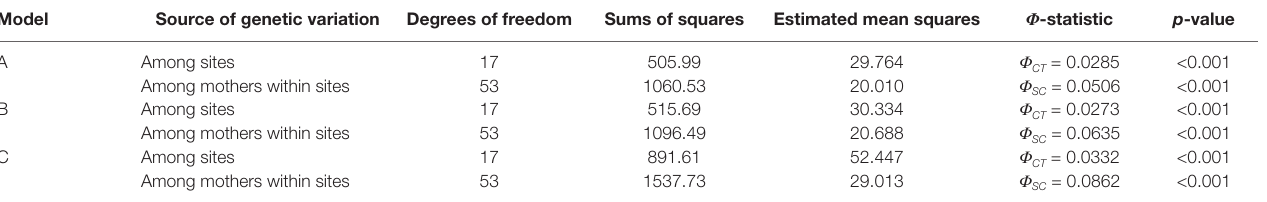
TaBLE 1 | Hierarchical AMOVA models testing pollen pool differentiation among sites ( Φ CT ) and among mothers nested within sites ( Φ SC ), with corresponding p- values from permutation tests.